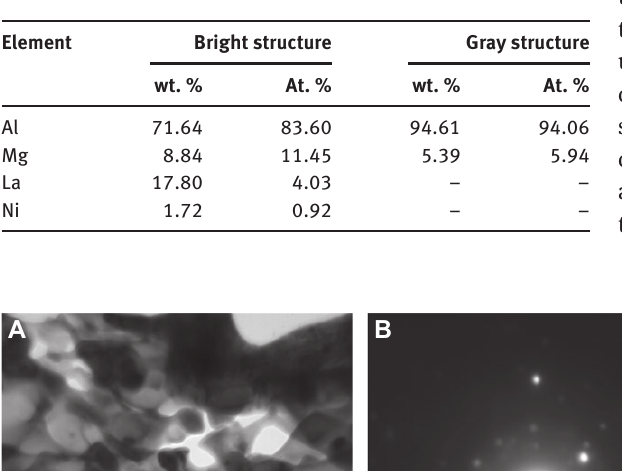
Table 1 The EPMA results in the sandwich structure region of the surface